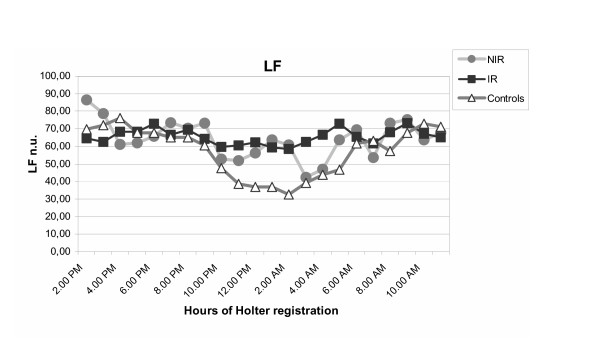
Circadian variation of LF in IR, NIR and in control group. Gray circles: group of non insulin resistant offsprings of type 2 diabetic patients; black squares: group of insulin resistant offsprings of type 2 diabetic patients; white triangles: control group; IR: insulin resistant offsprings of type 2 diabetic patients, NIR: non insulin resistant offsprings of type 2 diabetic patients, LF: low frequency.